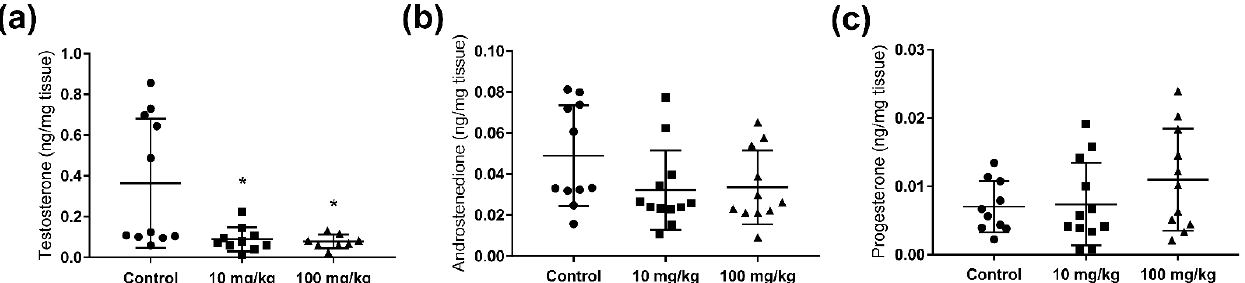
Figure 1. Persistent effects of five weeks oral DBP exposure on testis steroid hormone production in adult mice. Levels of testosterone ( a ), androstenedione ( b ), and progesterone ( c ) were measured by LC-HRMS in mouse testis collected one week after the last DBP administration. Values represent mean ± S.D. from 12 animals per group. Statistically significant differences from control are indicated as follows: * p < 0.05 (Kruskal–Wallis followed by Dunn’s